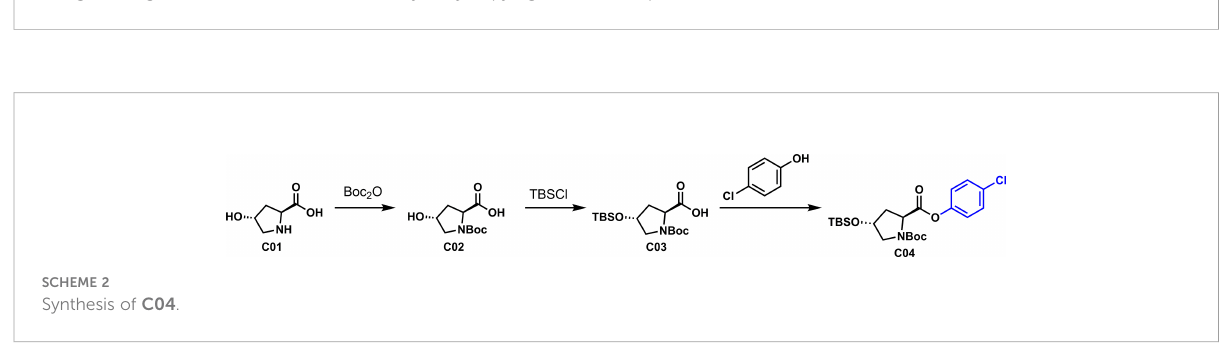
SCHEME 2 Synthesis of C04 .